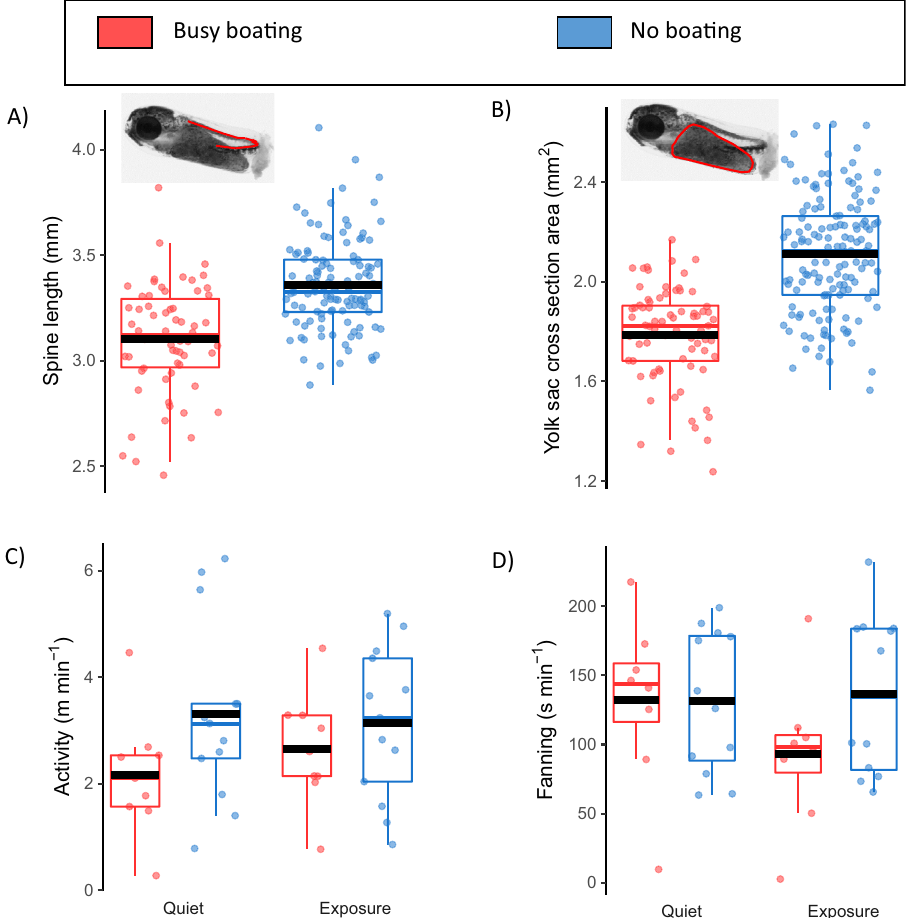
Fig. 2 Difference in embryonic development and parental-care behaviour in captive spiny chromis exposed to intermittent motorboat noise throughout development (busy-boating treatment in red) or protected from exposure to motorboat noise (no-boating treatment in blue). Embryonic development: A spine lengths were 0.23 ± 0.08 mm (7.4%) longer (LMM: Χ 2 1 = 8.10, p = 0.004) and B yolk sac areas were 0.30 ± 0.08 mm 2 (17%) larger (LMM: Χ 2 = 11.19, p < 0.001) at the end of the embryonic phase in no-boating compared with busy-boating. Parental care in quiet conditions for each rearing 1 condition compared with exposure to motorboat playback if reared in busy-boating (red) or a different ambient track if reared in no-boating (blue): C no difference in fanning in quiet periods (two-sample Welch ’ s t -test: t 13.2 = 0.01, p = 0.994) but the onset of motorboat noise decreased fanning (mean difference of 9 s min − 1 , two-sample Welch ’ s t -test: t 18.0 = 4.24, p < 0.001). There was a D trend towards greater activity in no-boating compared with busy-boating in quiet periods (mean difference = 1.16 m min − 1 , two-sample Welch ’ s t -test: t 20.0 = 1.91, p = 0.071), then activity in busy-boating increased at the onset of motorboat noise to reach a level similar to that in no-boating (mean difference = 0.67 m min − 1 , two-sample Welch ’ s t -test: t 16.7 = 2.51, p = 0.023). In all panels boxes show median and interquartile range (IQR), whiskers extend 1.5 * IQR above or below the box, black bars show means. Busy-boating broods = 9, no-boating broods =